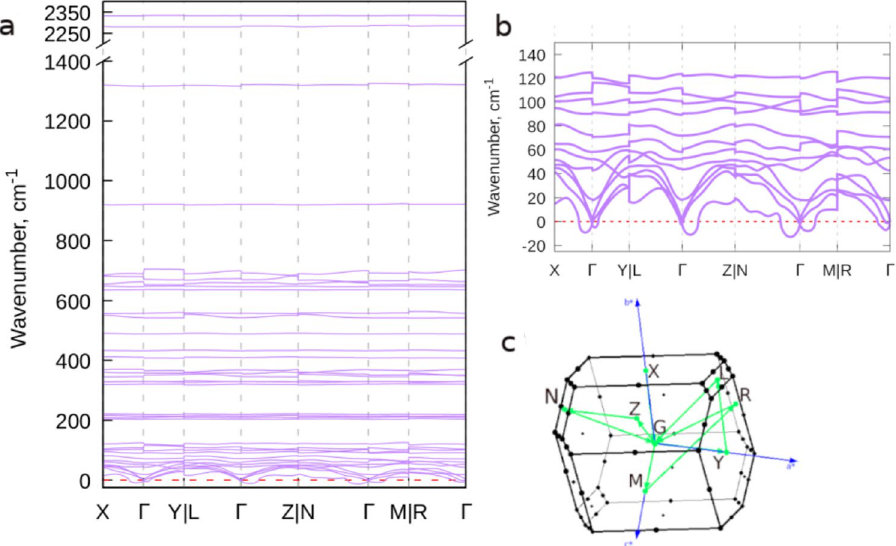
Figure 2. Calculated phonon dispersion of the N 5 AsF 6 at 0 K and 0 GPa along the high symmetry points of the first Brillouin zone: ( a ) the full calculated phonon dispersion. ( b ) phonon dispersion for frequencies lower than 1 240 cm − to allow for a clearer visualization of the soft phonon. ( c ) The high symmetry points path chosen in the first Brillouin zone. Unstable modes are shown in negative wavenumbers below the horizontal red